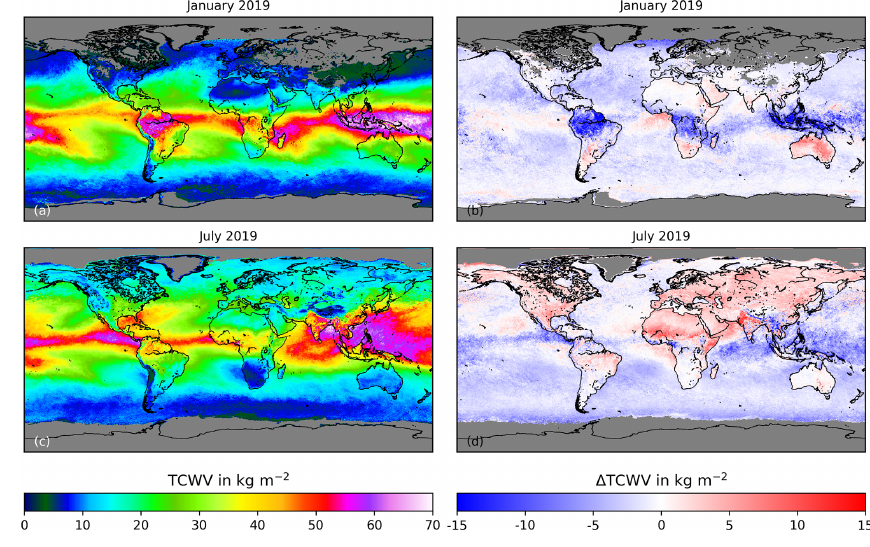
Figure 10. As Fig. 8 but for the S5P TCWV product from MPIC.